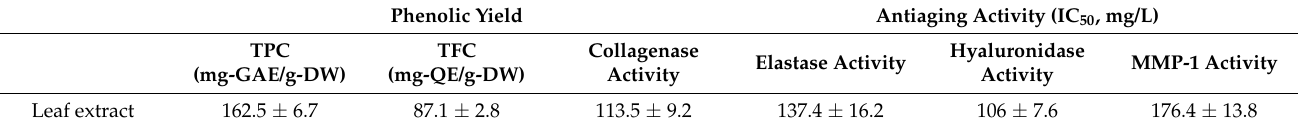
Table 1. TPC, TFC, and antiaging activity of the methanolic extract of C. formosanum leaves fermented with A. oryzae .